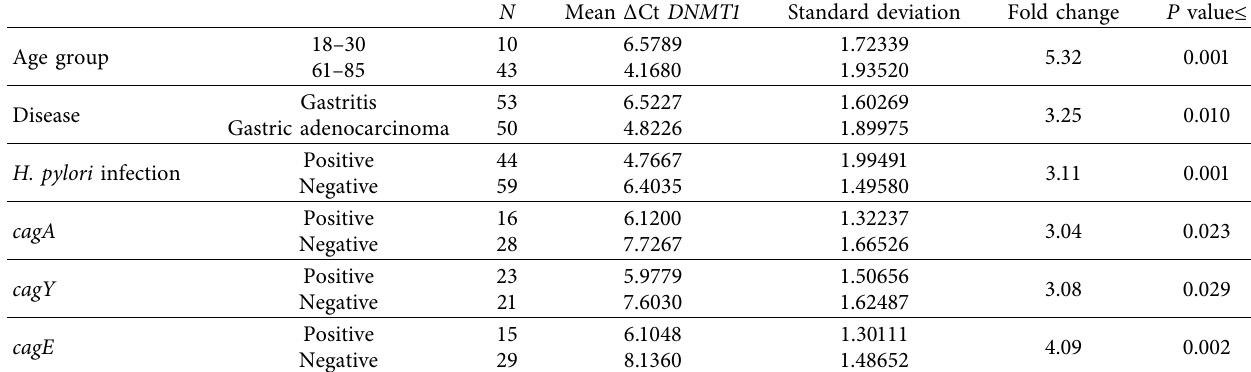
Table 9: Analysis of the relationship between gastric diseases, tumor grade, vacA cDNA, and H. pylori infection variables with DNMT1 gene Δ Ct ( T -test).